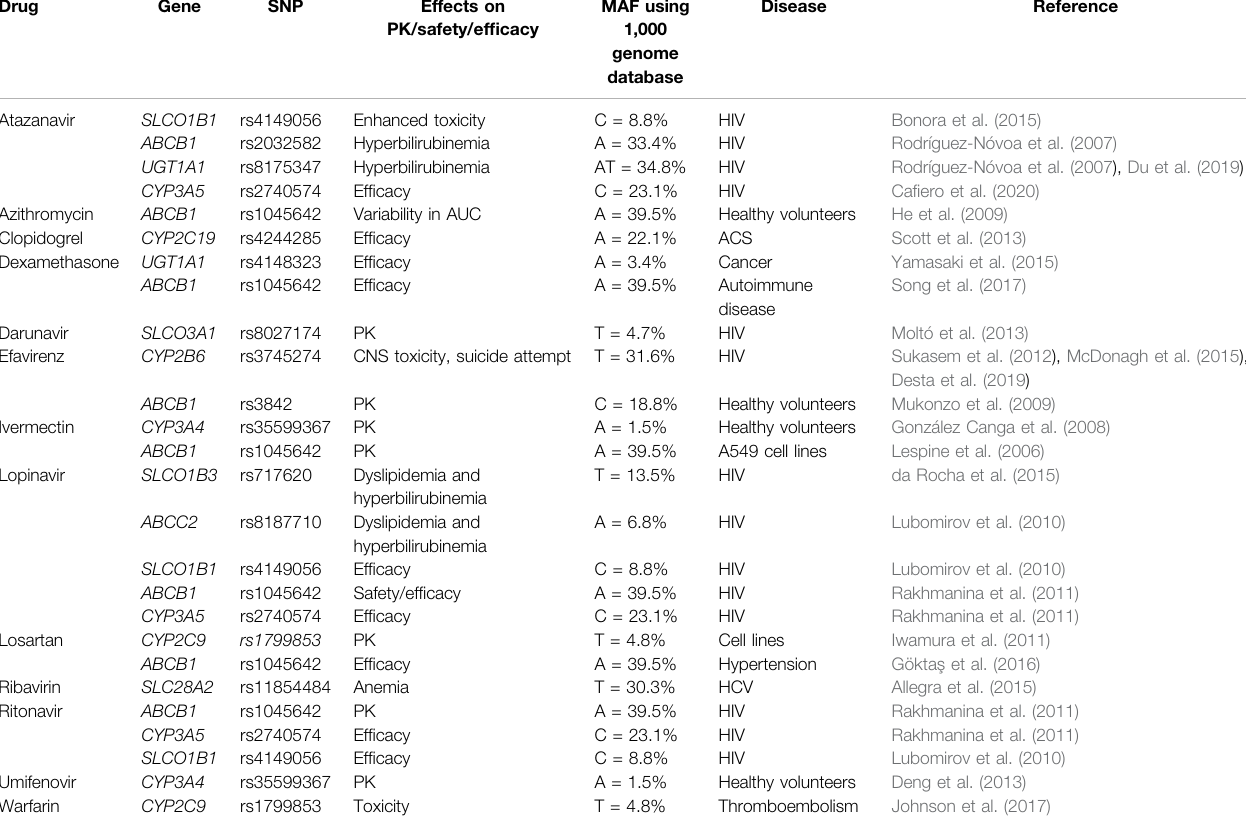
TABLE 2 | Evidence of pharmacogenetic associations of COVID-19 therapies in other disease conditions.